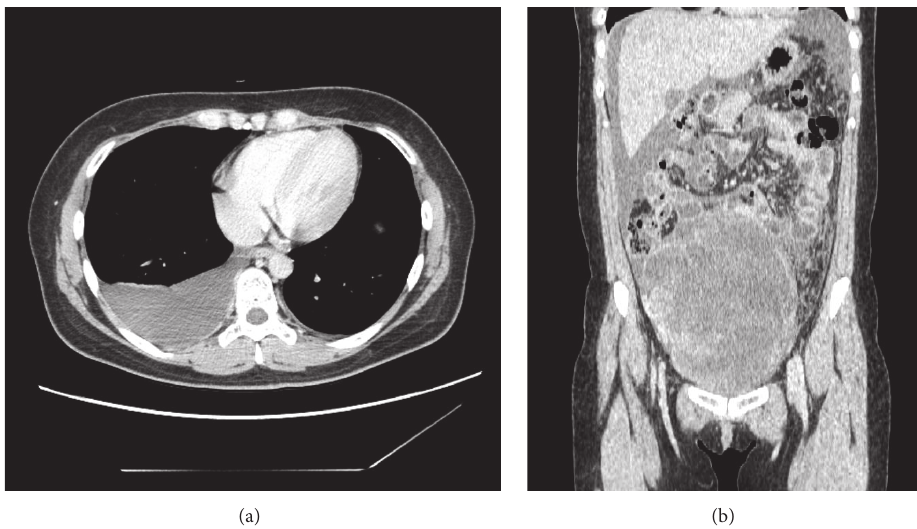
Figure 6: Contrast-enhanced CT scan in case 3 shows pleural effusion in the right thorax ((a) axial plane) and ascites along with a well- circumscribed and heterogeneously enhanced tumor of the rt. ovary ((b) coronal